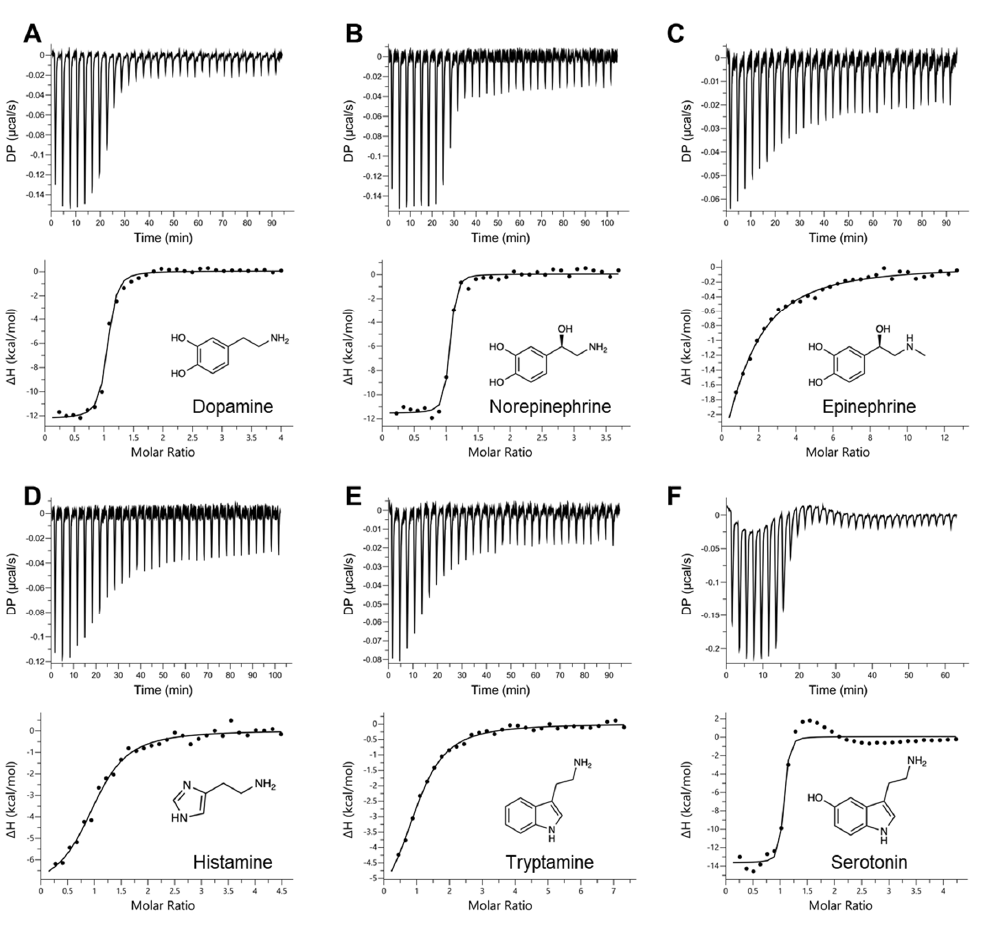
Figure 3. Binding of AlboD7L1 to biogenic amines by isothermal titration calorimetry. Binding experiments were performed on a VP-ITC microcalorimeter. The upper curve in each panel shows the measured heat for each injection, while the lower graph shows the enthalpies for each injection and the fit to a single-site binding model for calculation of thermodynamic parameters. Binding of AlboD7L1 to dopamine ( A ), norepinephrine ( B ), epinephrine ( C ), histamine ( D ), tryptamine ( E ), and serotonin ( F ). The insets show the names and chemical formulas for these compounds .